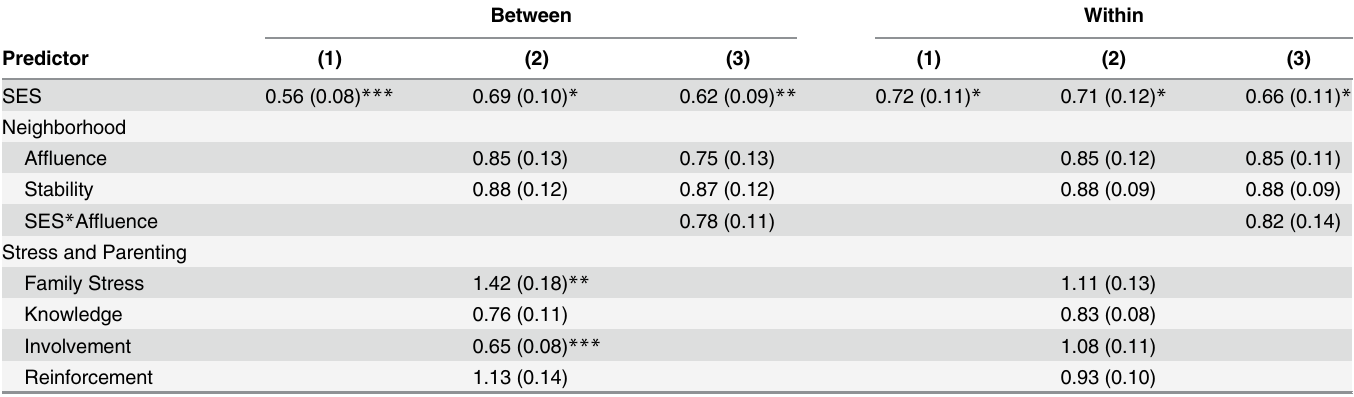
Table 4. Regression Models for Moderate Delinquency. Note . Odds ratios with standard errors in parentheses. Control variables omitted from table: sin- gle caretaker, ethnicity, age dummies, and wave dummy. Between Within Predictor